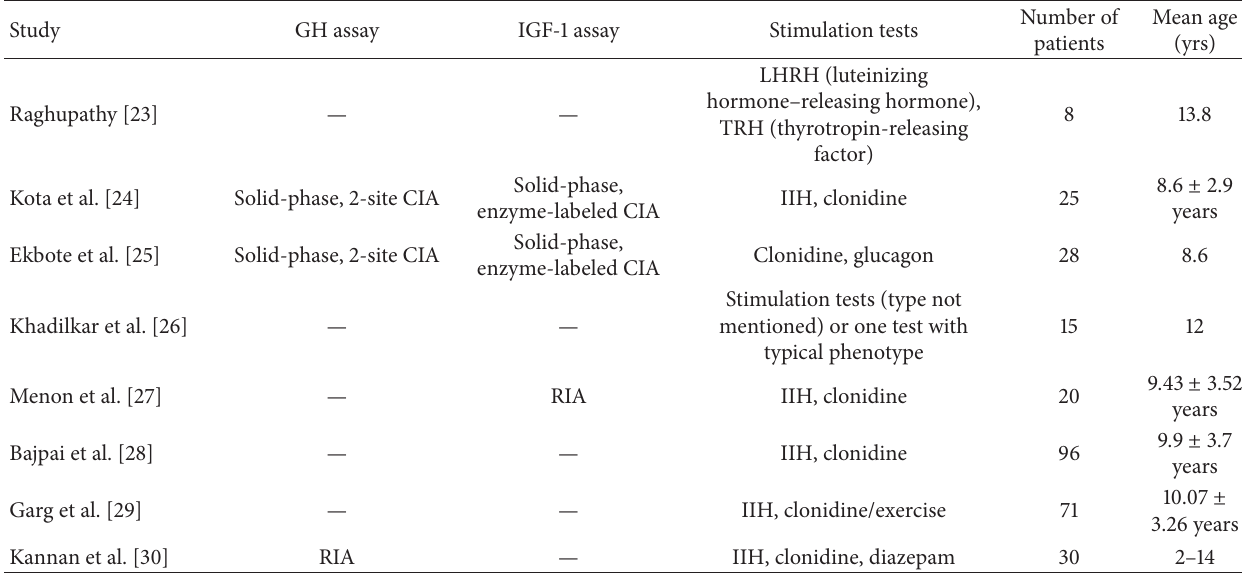
Table 1: Various tests for diagnosis of growth hormone deficiency.